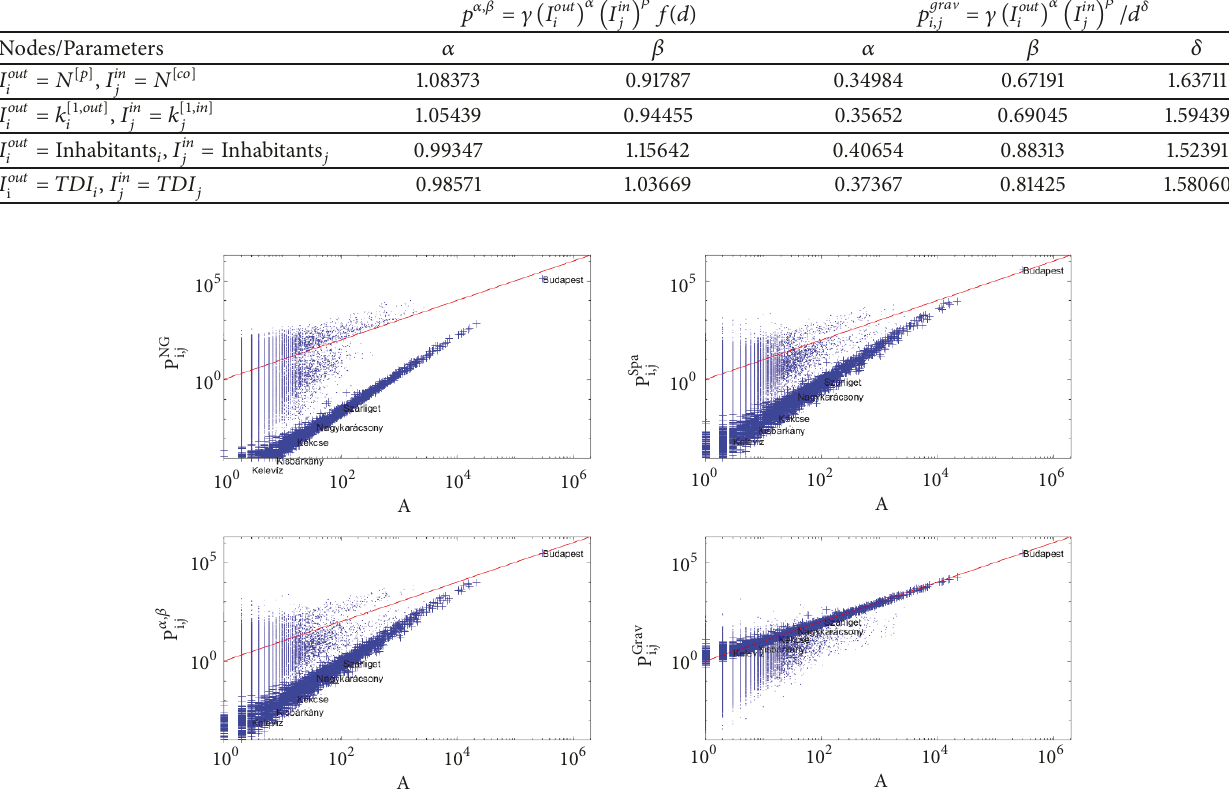
Figure 6: Comparison between the number of the edge weights 𝑎 [1] 𝑖,𝑗 and their estimated values 𝑝 [1] 𝑖,𝑗 generated by different null models on the town level (LAU 2) settlement hierarchy when 𝐼 𝑜𝑢𝑡 𝑖 = 𝑘 [1,𝑜𝑢𝑡] 𝑖 and 𝐼 𝑖𝑛 𝑗 = 𝑘 [1,𝑖𝑛] 𝑗 . The + symbols represent the inner connections that form a separate cluster. This plot directly reflects the goodness of fit as the model estimates the connections of the